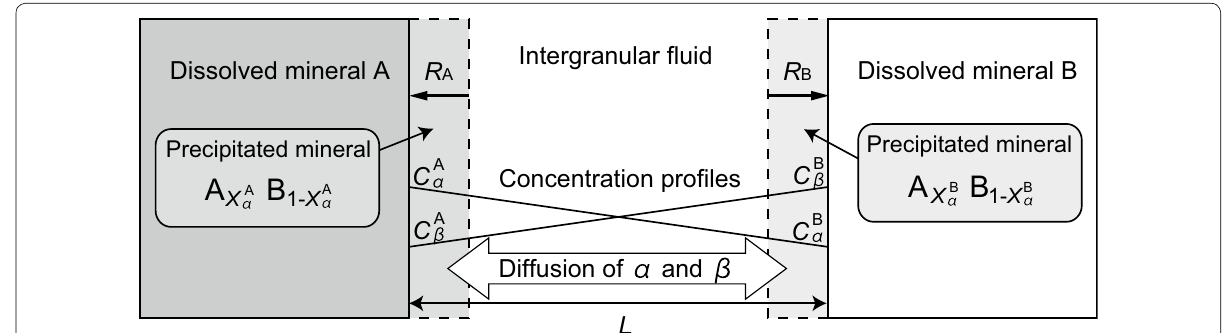
Fig. 1 Schematic of our model system. Two unstable minerals, A and B, are located on opposite sides and interact through a fluid conduit of length L . A replacement reaction occurs at each mineral surface. Minerals A and B react with rates R A and R B respectively, and the chemical formulas of their B 1 − X A B precipitates are expressed as A X A , and A X B 1 − X B α , respectively. Note that the precipitating solid-solution mineral α α α from the dissolving minerals, A and B. The concentration profiles of species α and β in the fluid channel are also shown. The linear concentration gradients of C α and C β are obtained under an assumed steady-state condition. The concentrations of α and β are completely coupled, indicating a single-component system (see text). Notably, the newly precipitated minerals are assumed to exist only at one side of the respective dissolved minerals and not to fill the fluid